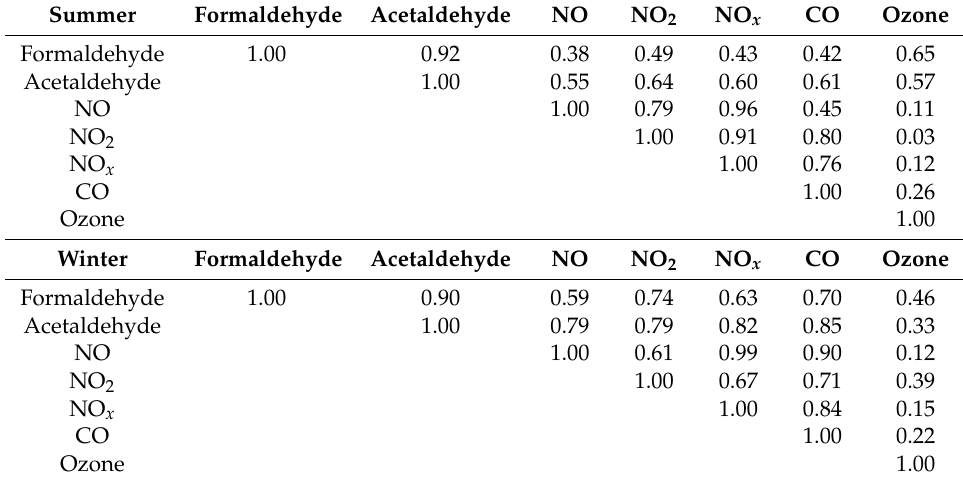
Table 4. Pearson’s correlation coefficients between aldehydes and other pollutants in summer and winter in the Metropolitan Area of S ã o Paulo